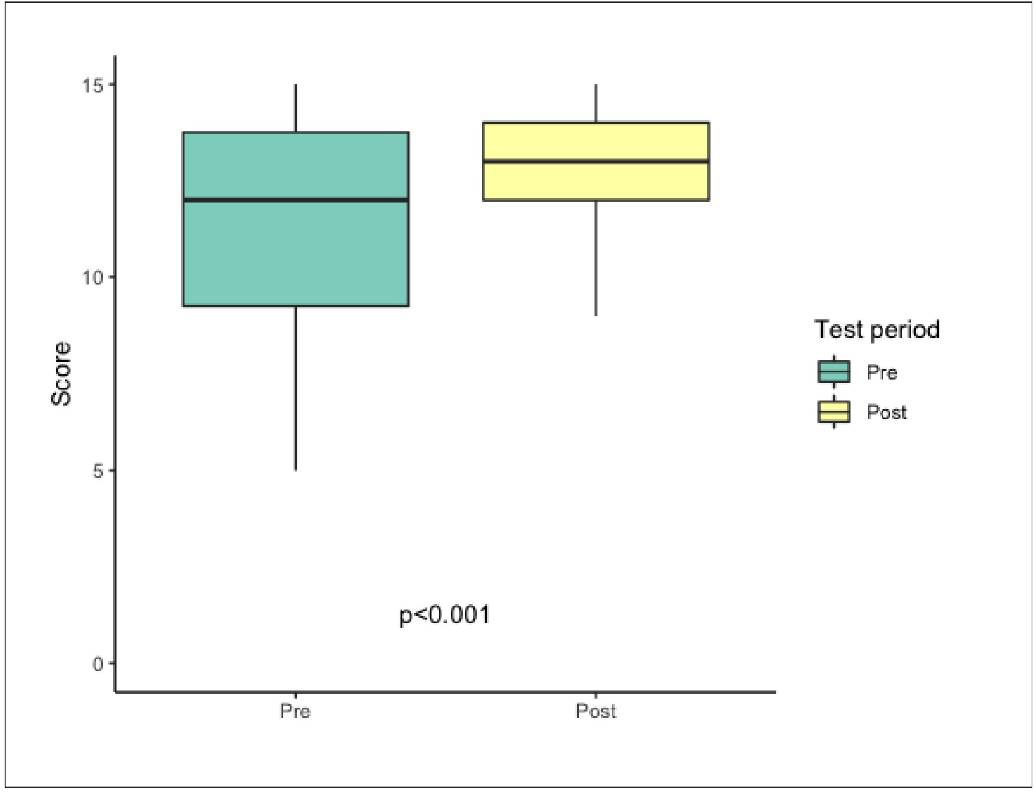
Fig 4. Pre and post-course knowledge assessment results. Box and whisker plots of the knowledge assessment results of the pre and post-course periods. There was a statistically significant increase in knowledge assessment scores in the post-course period (p < 0.001) by Wilcoxon signed-rank